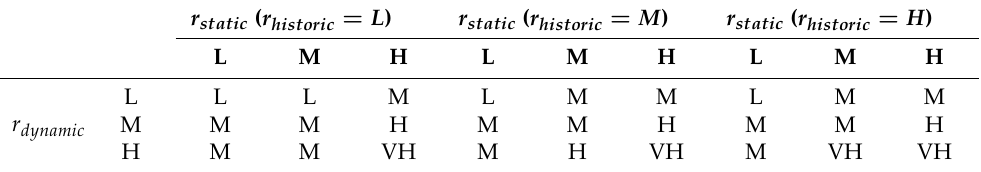
Table 2. Expert rule base of the output risk value based on nautical experts’ knowledge. r static ( r historic = L )